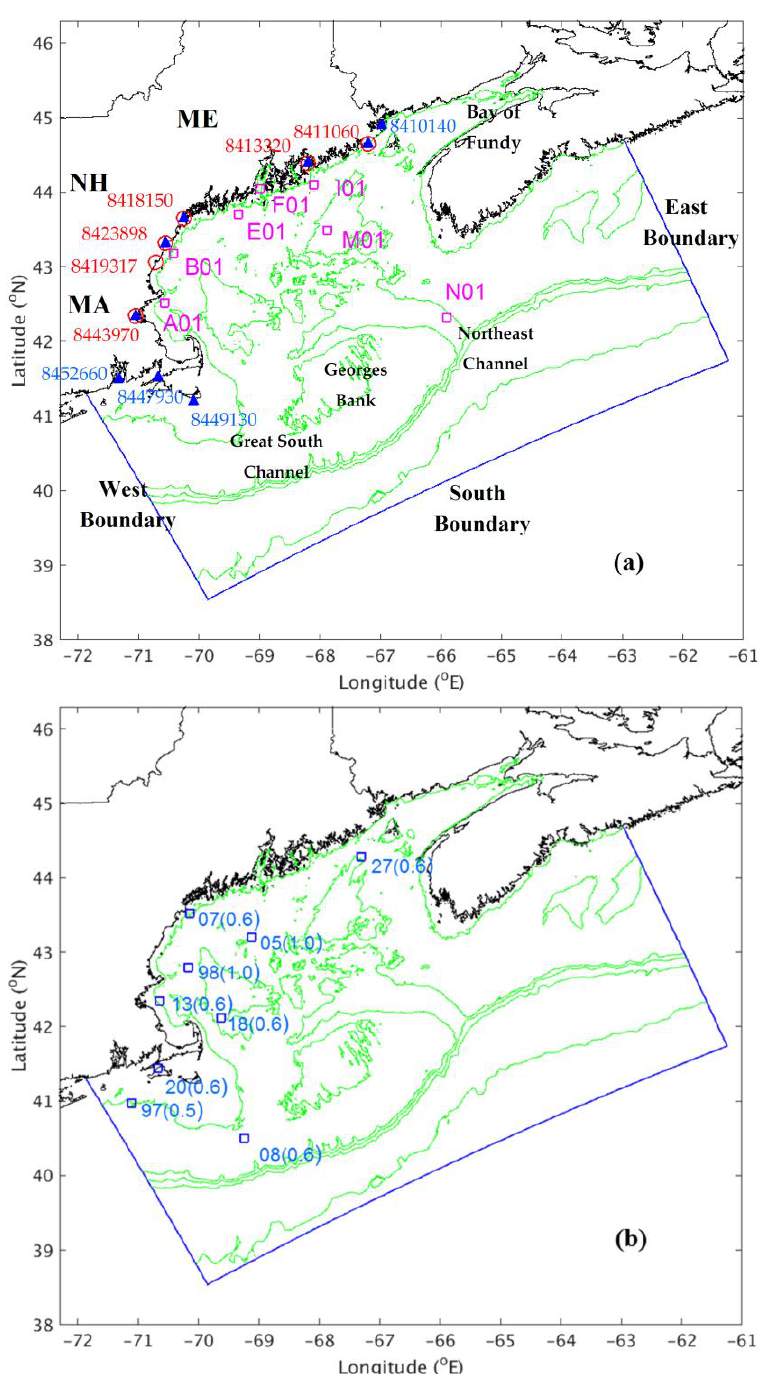
Figure 1. Map of the Gulf of Maine (GoM)/Georges Bank (GB) region and the GoMOFS model domain. Green lines represent the 50, 200, 500, 1000, and 3000-m isobaths. Blue lines denote the three open ocean boundaries of the model domain. ( a ) Map of observation stations: the CO-OPS water level stations (red circles) and water temperature stations (filled blue triangles), and the NeraCOOS buoys (magenta squares). The station IDs are labeled near the location markers. The measurement depths of the CO-OPS stations are 3.3 m (8410140), 2.4 m (8411060), 2.9 m (8413320), 4.9 m (8418150), 3.3 m (8419317), 2.9 m (8443970), 2.0 m (8447930), 1.2 m (8449130), and 1.8 m (8452660). The NeraCOOS depths are listed in Table 1; ( b ) Map of NDBC buoy stations. The station IDs are labeled near the location marks. Three leading digits “440” of each ID number are omitted for the clarity of illustration. The numbers in the parentheses following the IDs represent the measurement depths (in meters) relative to the sea surface.